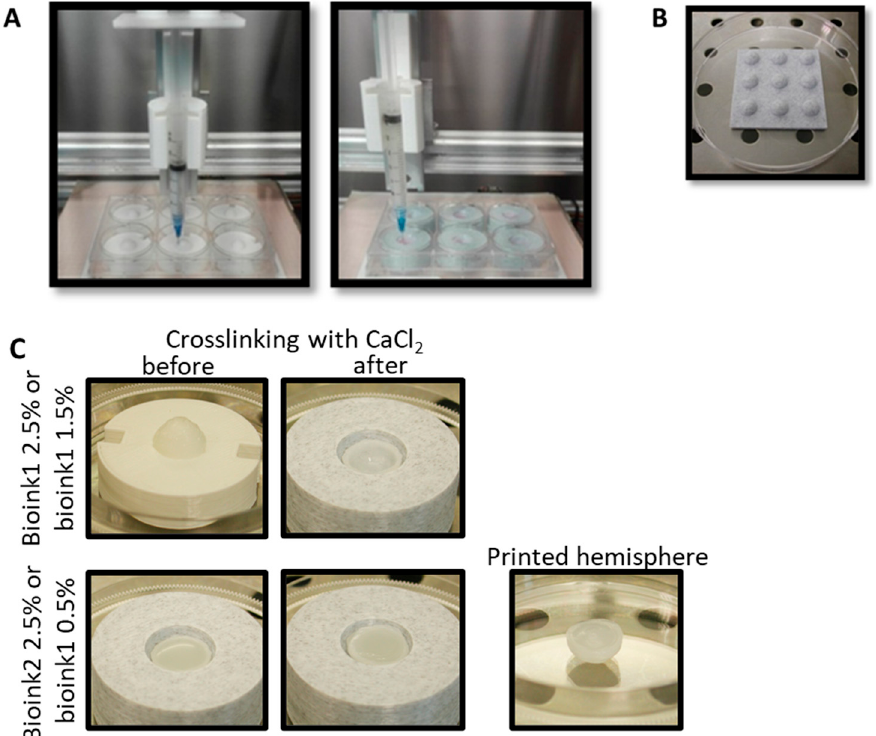
Figure 5. The deposition of the bioink in the biosafety cabinet. ( A ) on the left, the print of the hollow hemispheres (bioink1 2.5% or 1.5%) on white PLA molds with 9 mm diameter, ( A ) on the right, the print of bioink2 2.5% or bioink1 0.5% inside the crosslinked hollow hemisphere on grey PLA molds. ( B ) Grey PLA molds with 7 mm diameter. ( C ) Printed bioinks before and after crosslinking with CaCl 2 and final 3D structure (hemisphere).